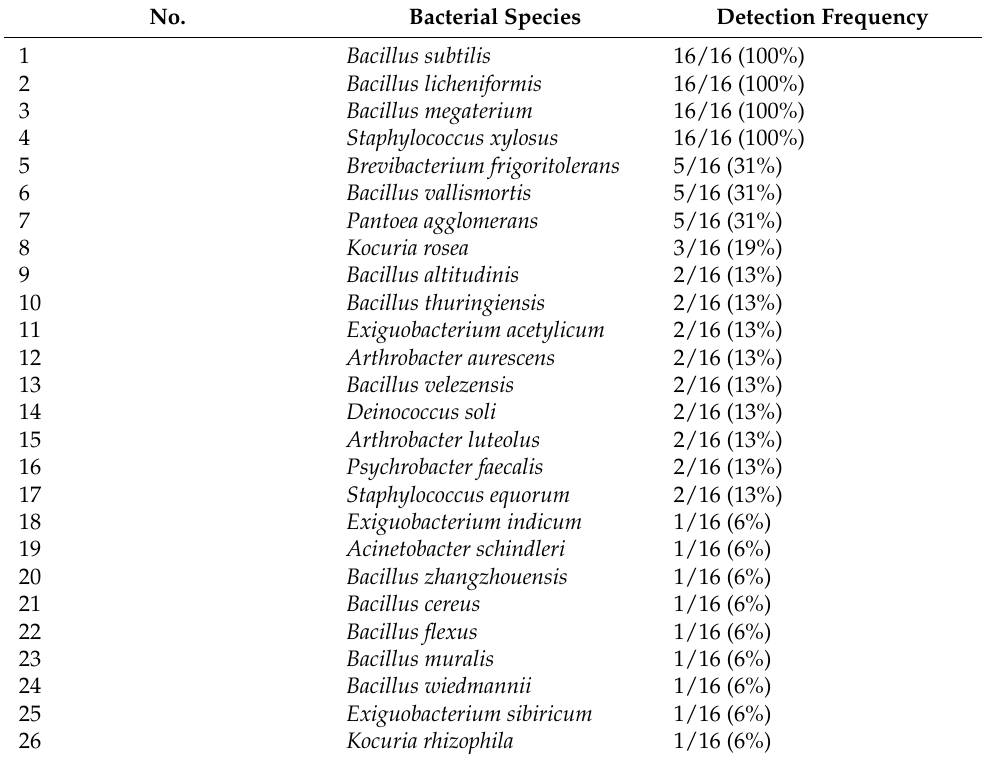
Table 3. Detection frequency of airborne bacteria.